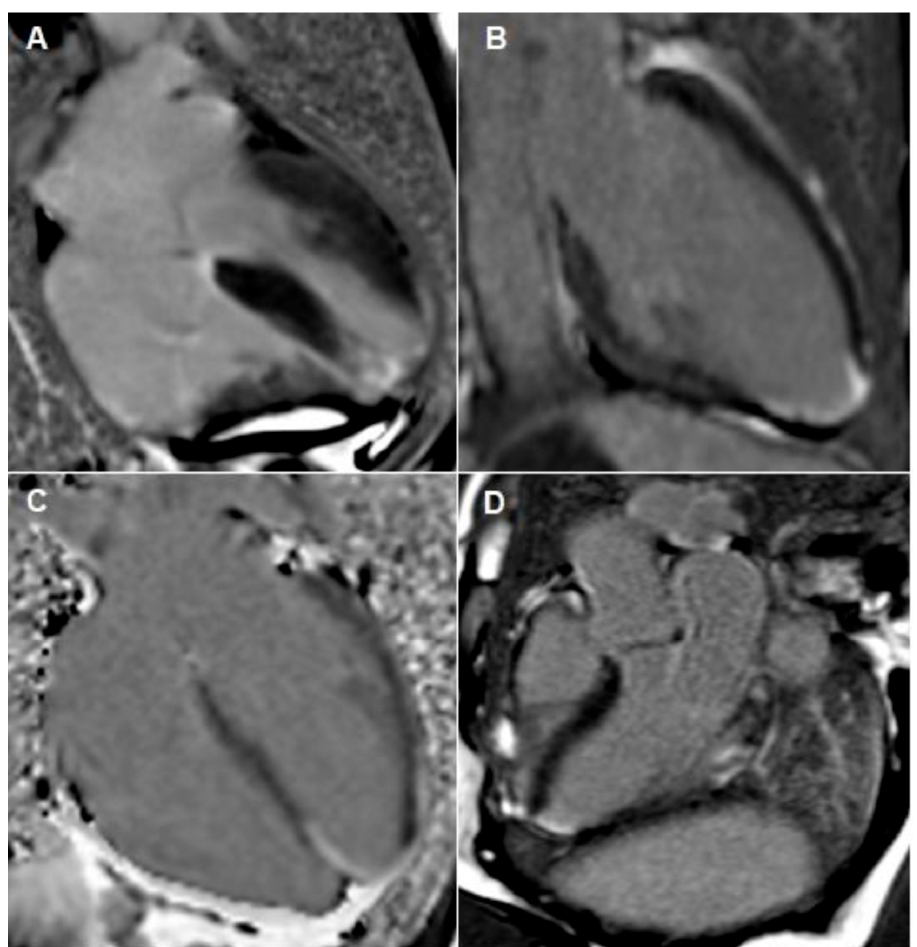
Figure 4. Cardiac MRI images taken during both admissions. ( A – C ) outlines apical infarction. These images outline focal transmural late gadolinium enhancement in apical septum with sub-endocardial myocardial late gadolinium enhancement extending into the distal apical anterior, apical inferior and true apical segments. Image ( D ) outlines inferior-lateral infarction, which occurred during her second admission.